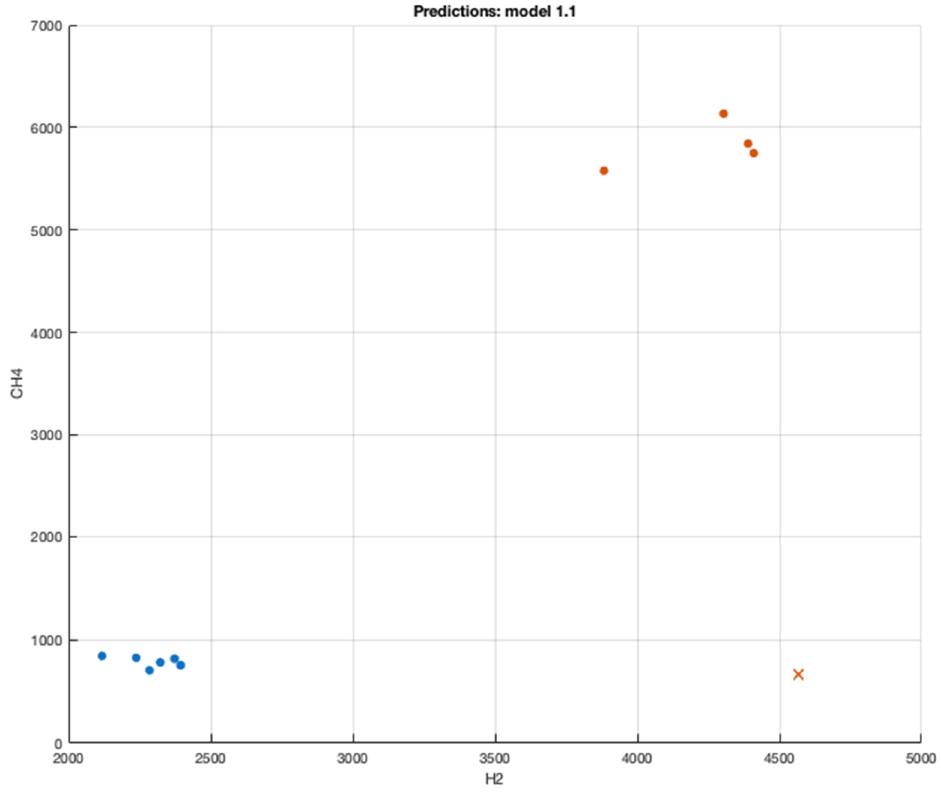
Figure 15. H (cid:2870) versus CH (cid:2872) . Blue and orange (•)—raw data, orange and blue (×)—predicted data. Figure 15. H 2 versus CH 4 . Blue and orange ( • )—raw data, orange and blue ( × )—predicted data. Further, the ML algorithms were compared in terms of accuracy (%), prediction speed Further, the ML algorithms were compared in terms of accuracy (%), prediction (objects/sec) and training time (sec), as tabulated in Table speed (objects/sec) and training time (sec), as tabulated in Table 7. Table 7. SVM 4 DGA classification outcomes.